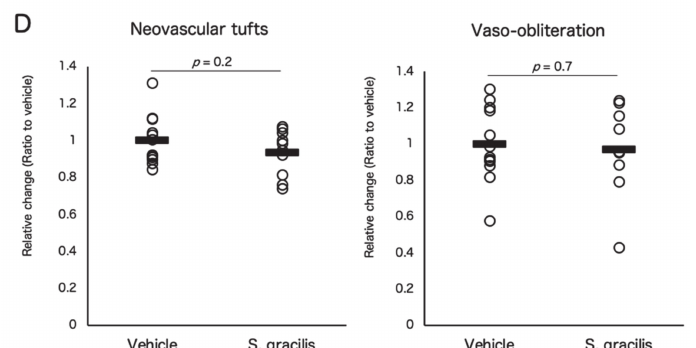
Figure 4. Oral administration of Spratelloides gracilis ingredients show a tendency to suppress retinal neovascularization in a murine oxygen-induced retinopathy (OIR) model. ( A ) A schematic illustration of the oxygen-induced retinopathy (OIR) procedure. Vehicle ( n = 6) or S. gracilis ( n = 5) was orally administered from P12 to P16. ( B ) Mean body weight change of mice. The average body weight of the S. gracilis group did not di ff er from that of the vehicle group through the administration period. ( C ) Representative images of retinal vasculature staining with isolectin B4. Areas of neovascular tufts (red) or vaso-obliteration (yellow) are highlighted. ( D ) Quantification of neovascular tufts and vaso-obliteration (right) in OIR as a percentage of the total retinal area. Note that S. gracilis tended to suppress neovascular tufts while no significant di ff erence was observed in vaso-obliteration. n.s., not significant. Error bars indicate mean plus SD.